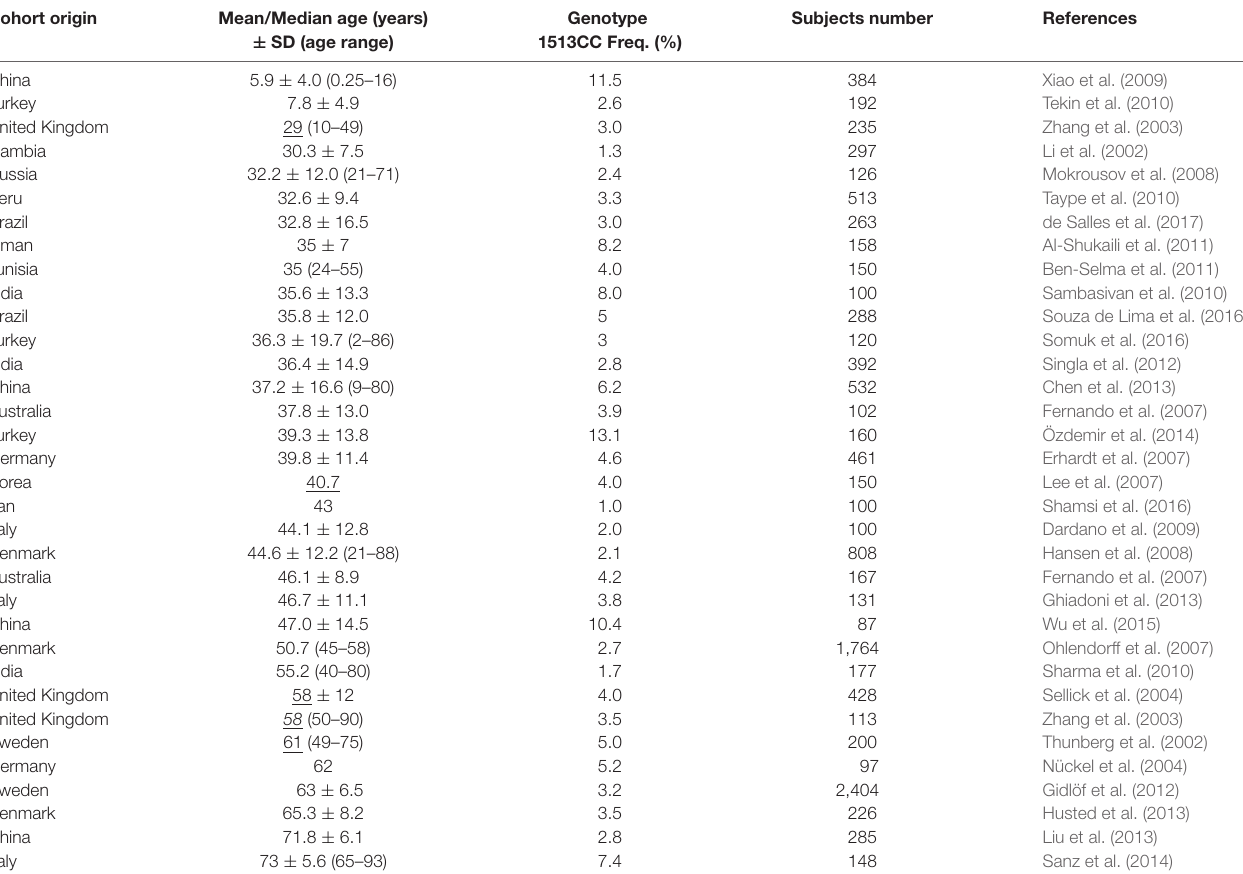
TABLE 2 | Age and 1513CC P2RX7 genotype frequency in different population